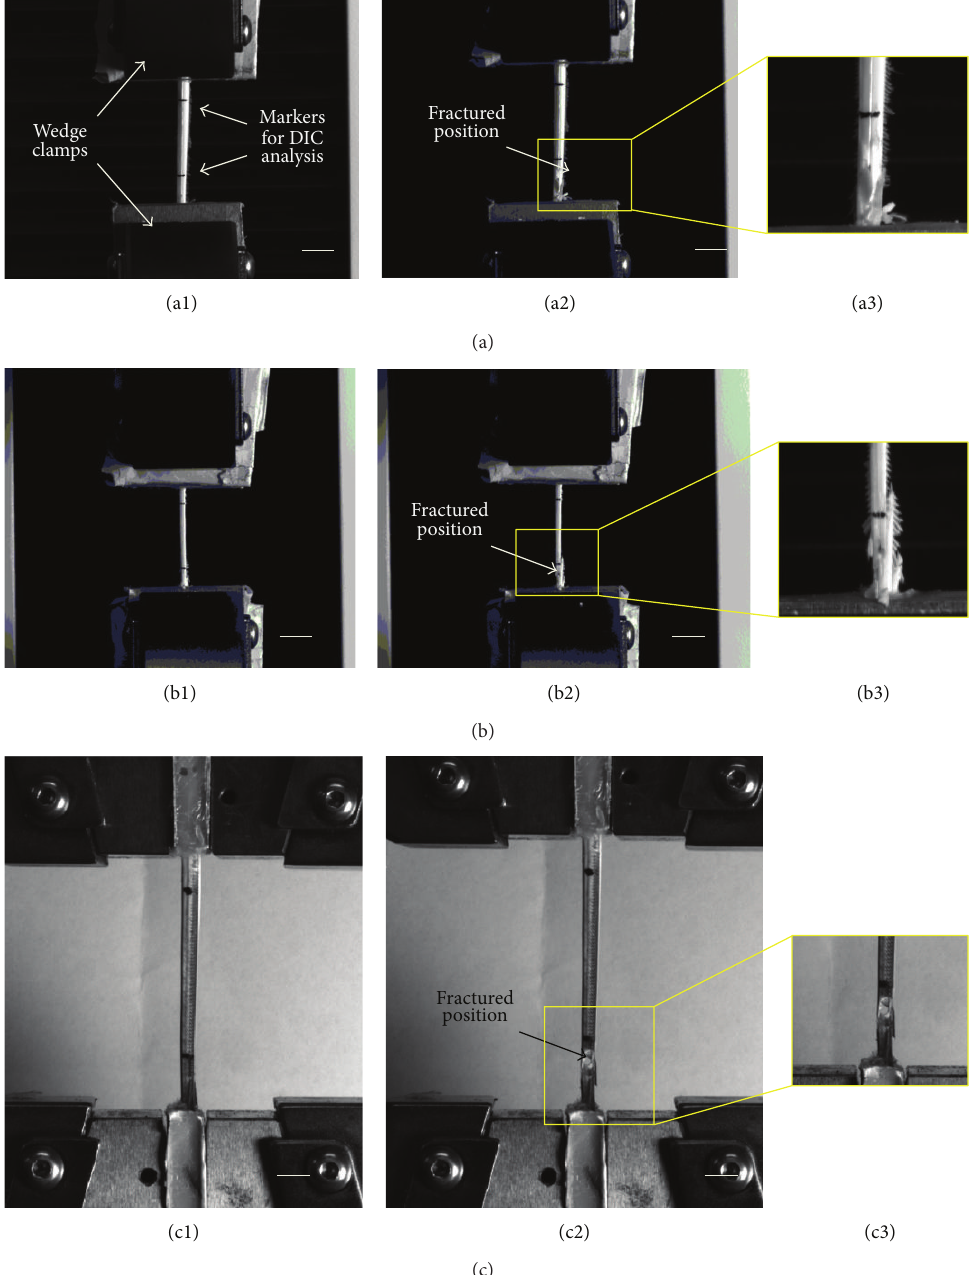
Figure 4: Experimental specimens in the clamps, scale bar: 1mm. (a1) Fixed long-eared owl specimen before test. (a2) Breaking long-eared owl specimen after tensile process. (a3) Breaking point close-up of the owl specimen. (b1) Fixed pigeon specimen before test. (b2) Breaking pigeon specimen after tensile process. (b3) Breaking point close-up of the pigeon specimen. (c1) Fixed golden eagle specimen before test. (c2) Breaking golden eagle specimen after tensile process. (c3) Breaking point close-up of the golden eagle specimen.